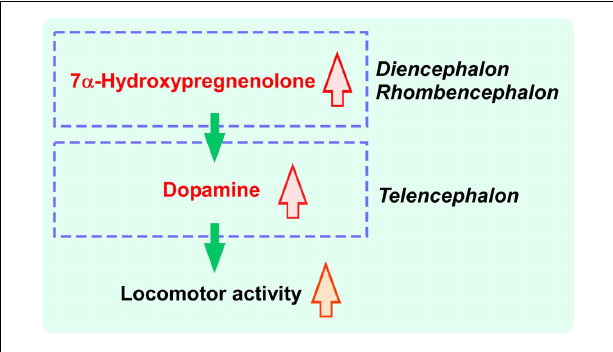
FIGURE 2 | Schematic model depicting the action of 7 α -hydroxypregnenolone on the regulation of locomotor activity in male newt. 7 α -Hydroxypregnenolone synthesized actively in the diencephalon and rhombencephalon, by acting on dopaminergic neurons localized in the PT andVTA, may induce dopamine release from their terminals in rostral brain regions, notably in the striatum and nucleus accumbens (NA), and consequently increase locomotor activity of male newt. See the text for